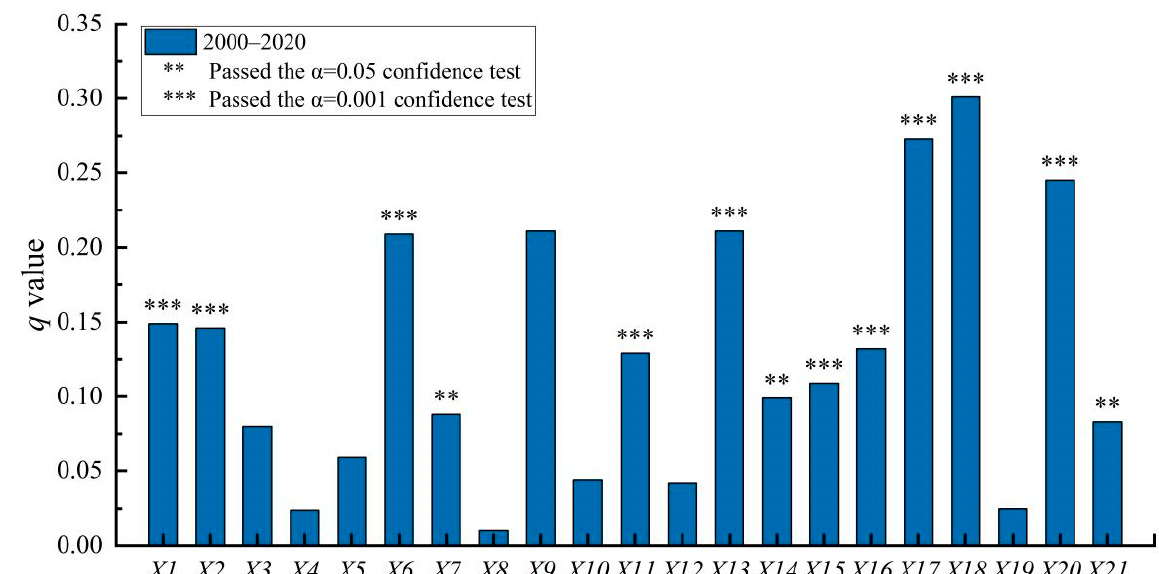
Figure 5. Contribution rate of population-shrinkage influencing factors in the North–South Transi- tional Zone of China (2000–2020).